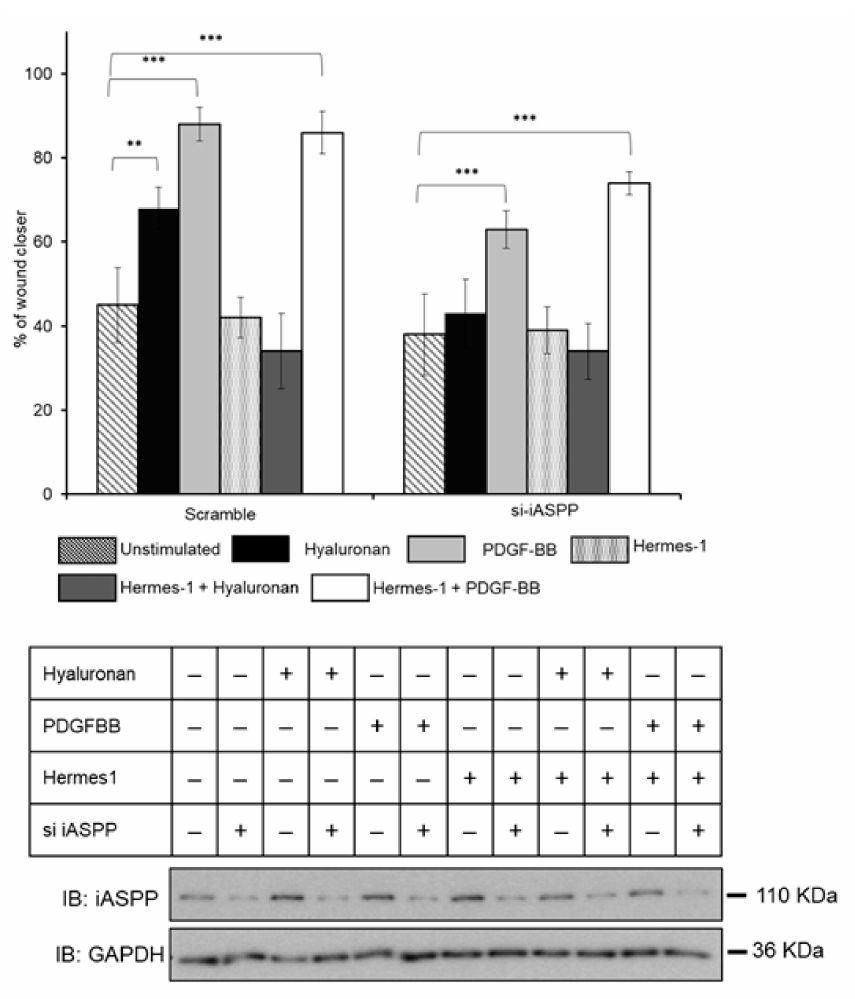
Figure 7. iASPP is required for hyaluronan-induced fibroblast migration. Confluent cultures of hTERT-BJ fibroblasts, transfected with iASPP siRNA or scrambled siRNA, were scratched and then stimulated, or not, with hyaluronan or PDGF-BB in DMEM medium containing 0.1% FBS. The wound size was examined after 24 h of culturing pictures were taken and analyzed using TScratch program (a software tool for automated analysis of wound-healing assays). The effect of hyaluronan stimulation and knock-down of iASPP on the migration of fibroblasts, are shown in bar graphs. The iASPP knock-down efficiency was determined by immunoblotting using an iASPP antibody; equal loading was determined by immunoblotting for GAPDH. The data are plotted in bar graphs representing the mean ± SD of at least three independent experiments (** p < 0.01 and *** p <0.001 Student’s t -test). The uncropped blots are shown in File